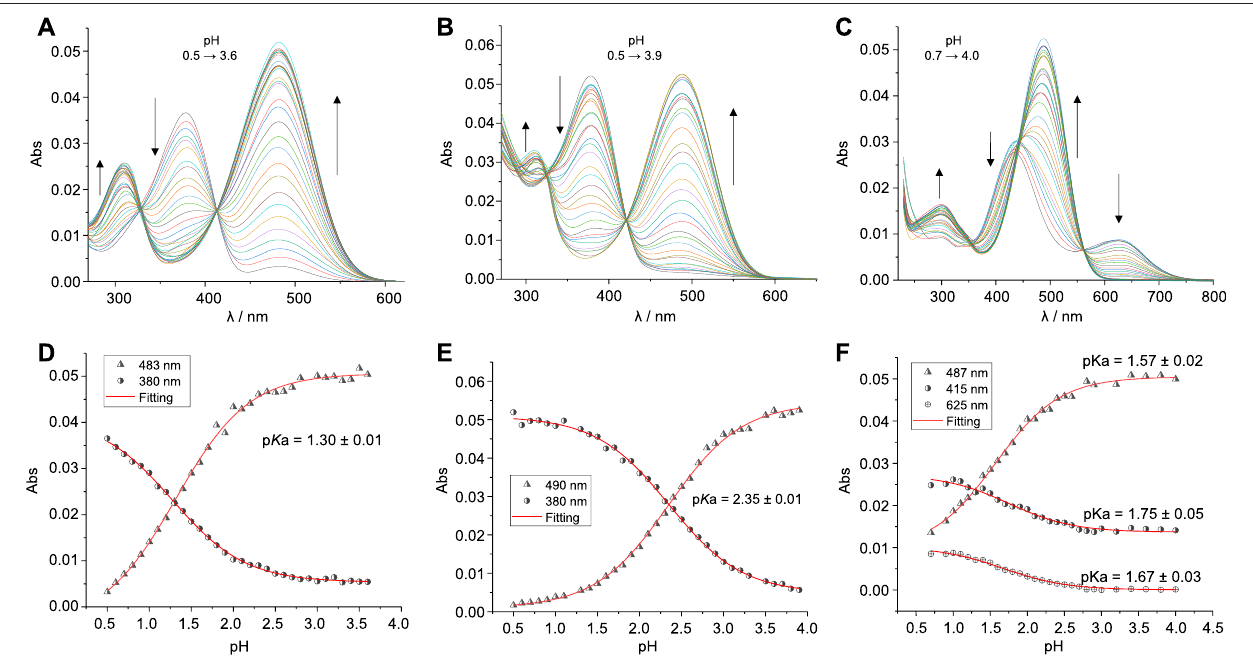
FIGURE2| Top : Modi fi cationsoftheabsorptionspectrabyacid-basetitrationsatdifferentpHvalues(0.5 – 3.9)for SAC1-3 (1.5 μ M;T=25.0 ° C)inmethanol/water, 3/7 (v/v): (A)SAC1 , (B) SAC2 and (C) SAC3 . Bottom: Acid base titration curves at different absorptionwavelengths (represented by different symbols) and the fi ttingof Eq. 1 to experimental data (represented by red continuous lines): (D) SAC1 , (E) SAC2 and (F) SAC3 .